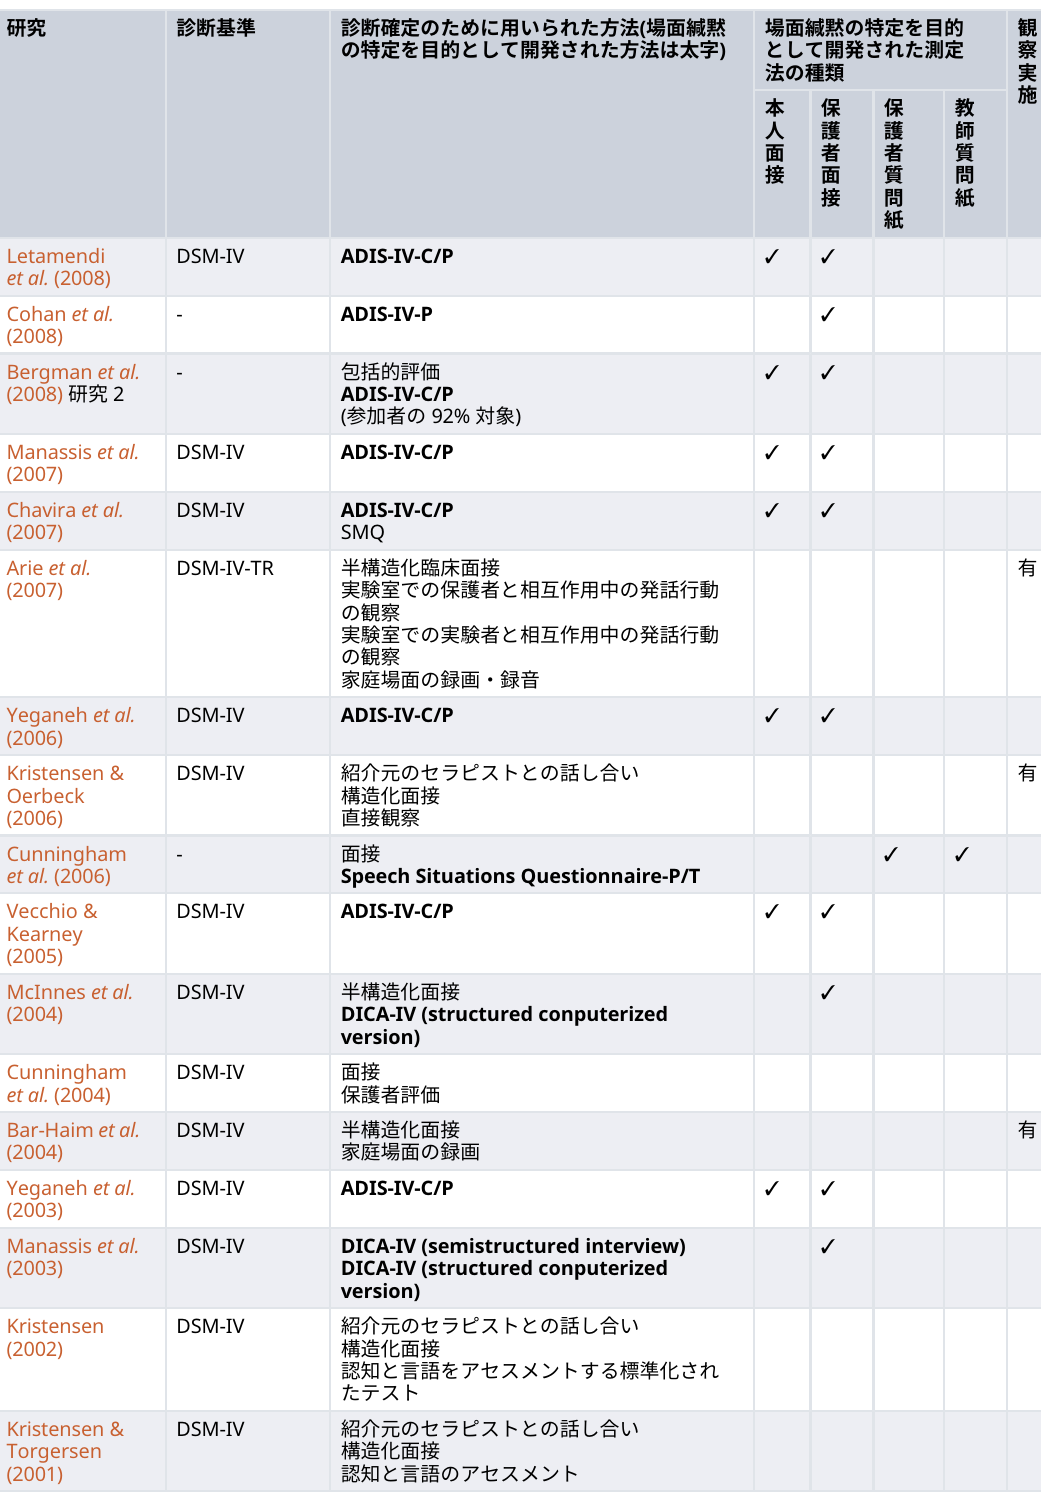
Table 2. 場 面 緘 黙 診 断 確 定 に 用 いられた 手 法 . ( 続 き ) 研 究 診 断 基 準 診 断 確 定 のために 用 いられた 方 法 ( 場 面 緘 黙 の 特 定 を 目的 として 開 発 された 方 法 は 太 字